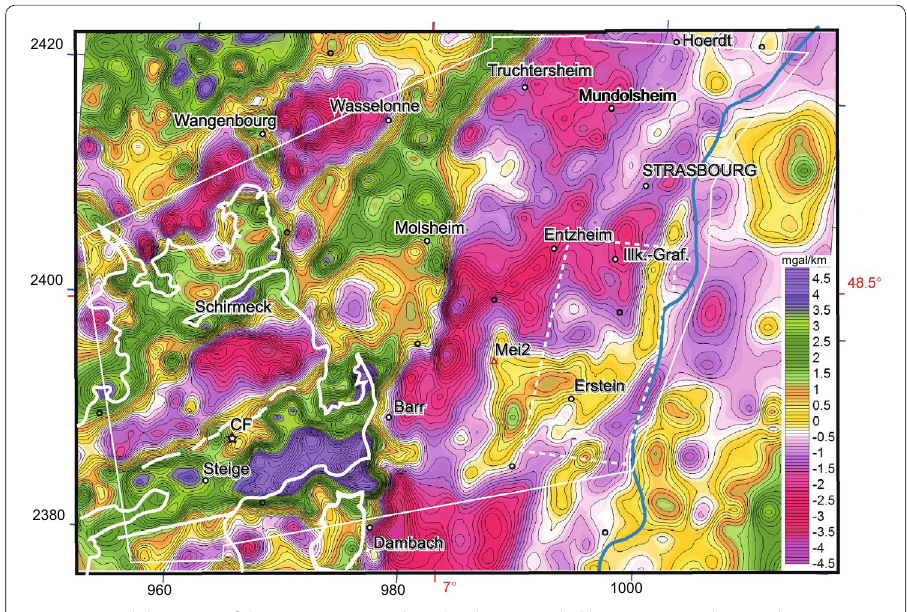
Fig. 5 Vertical derivative of the Bouguer anomalies. The data compiled by Rotstein et al. (2006) have been complemented by the new data acquired and processed in the frame of the geothermal project. The red-to-violet anomalies are mainly associated with granites, the intermediate white–yellow–orange anomalies with Palaeozoic sediments and gneisses, and the green and dark blue anomalies with mafic volcanites, diorites and Early Palaeozoic schists. Geographical and extended Lambert II